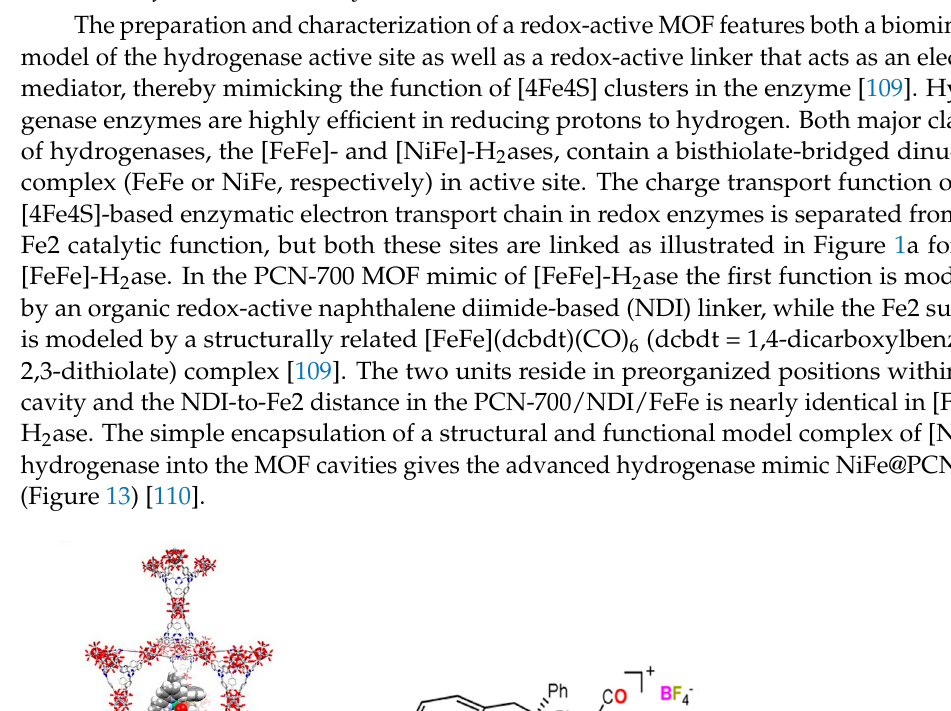
Table 2. Models of redox-active enzymes.